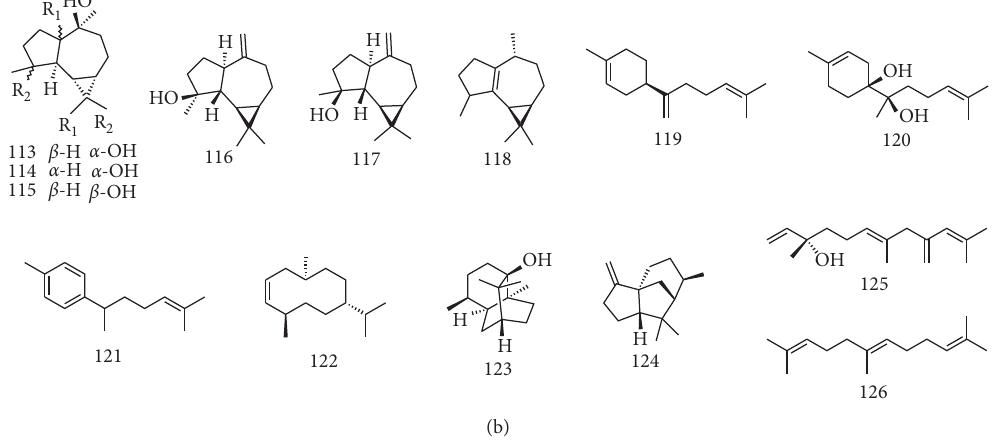
Figure 2: The structures of sesquiterpenes from Cinnamomum